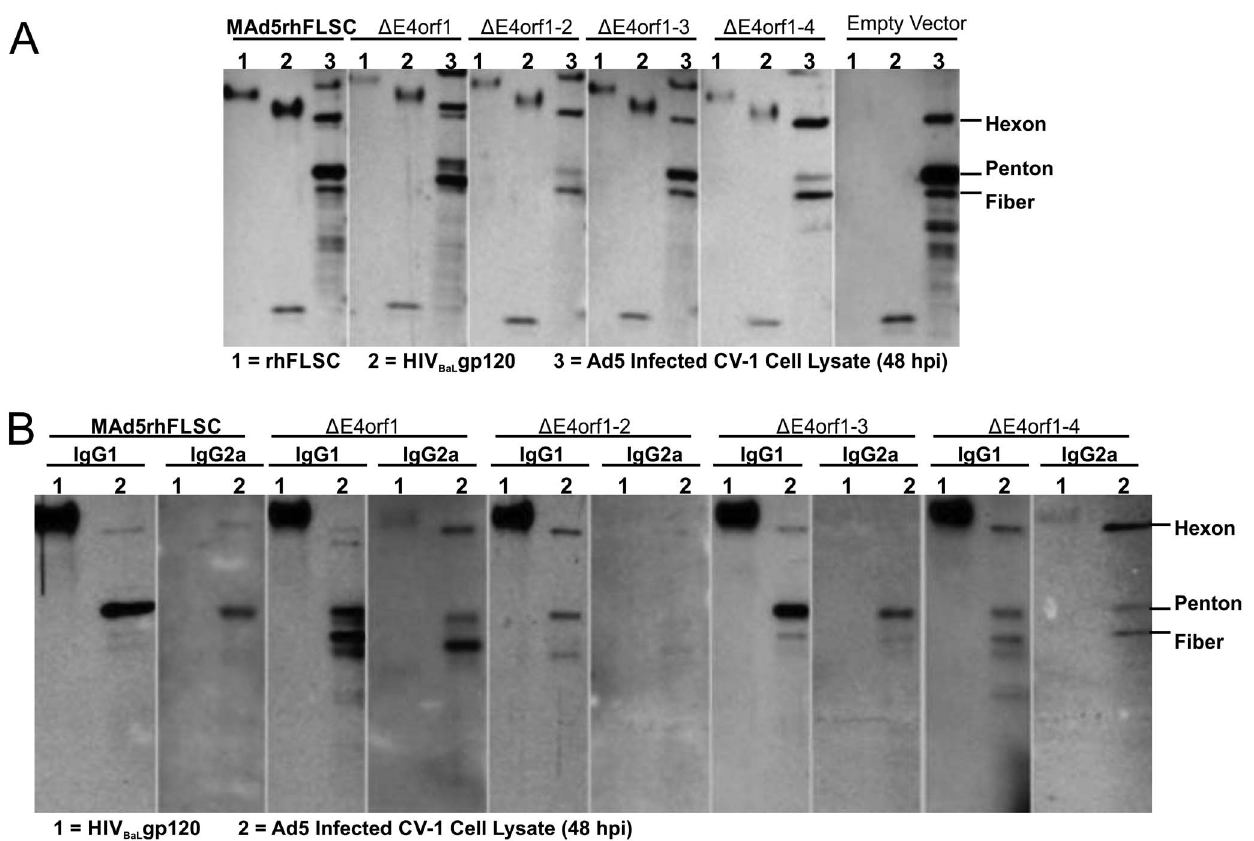
Figure 10. Sera from mice vaccinated with MAd5rhFLSC or the E4 -deletion variants differentially recognize Ad antigens. ( A ) Equal amounts of recombinant rhFLSC protein, HIV BaL gp120 protein, or lysate from CV-1 cells collected 48 hpi were separated by SDS-PAGE, transferred to nitrocellulose, and exposed to pooled sera from mice vaccinated with the indicated viruses. The washed blots were then exposed to HRP conjugated anti-mouse IgG. ( B ) Similarly, blots of HIV BaL gp120 protein and lysate from CV-1 cells collected 48 hpi were incubated with pooled mouse sera and then with HRP conjugated anti-mouse IgG1 or to HRP conjugated anti-mouse IgG2a as indicated. Figures shown are representative of 2–5